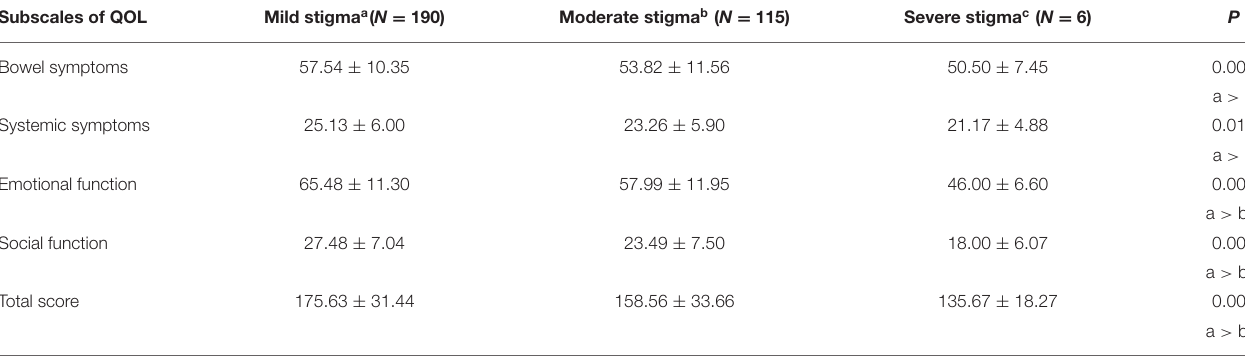
TABLE 3 | Comparison of quality of life between the patients with mild, moderate and severe perceived stigma ( N = 311). Subscales of QOL Mild stigma a ( N = 190) Bowel symptoms Systemic symptoms Emotional